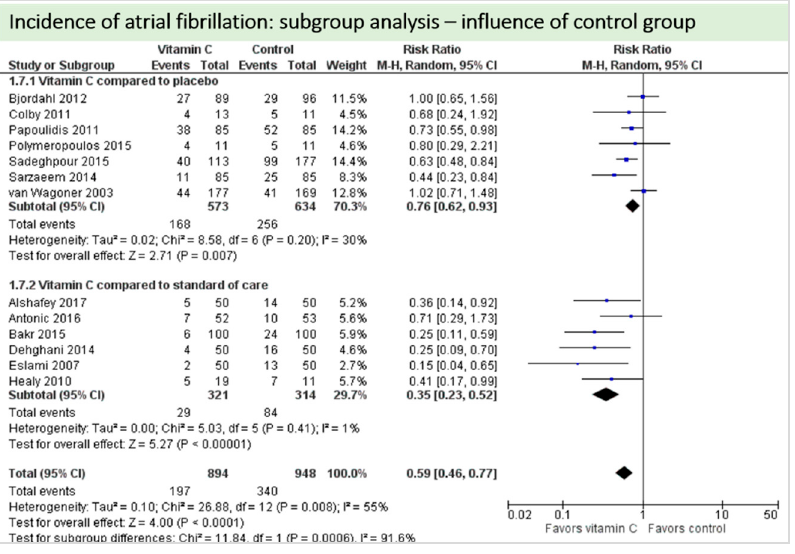
Figure 17. Incidence of atrial fibrillation: subgroup analysis—influence of control group.